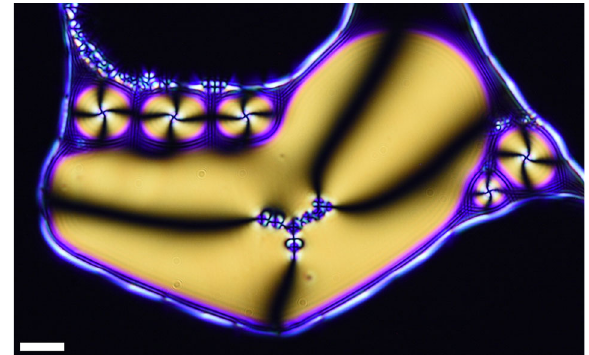
Fig. 5 Triangular satellite self-assembly in 2D. Polarized microscopy image of a nematic droplet in the shape of a deformed disc in 2D space (third dimension close on the inclusion diameter scale) with normal boundary conditions. Inside the nematic domain, a 2D structure comprising of linear and triangular segments of inclusions with radial boundary conditions is formed, mimicking the shape of its container. Scale bar: 10 μ m